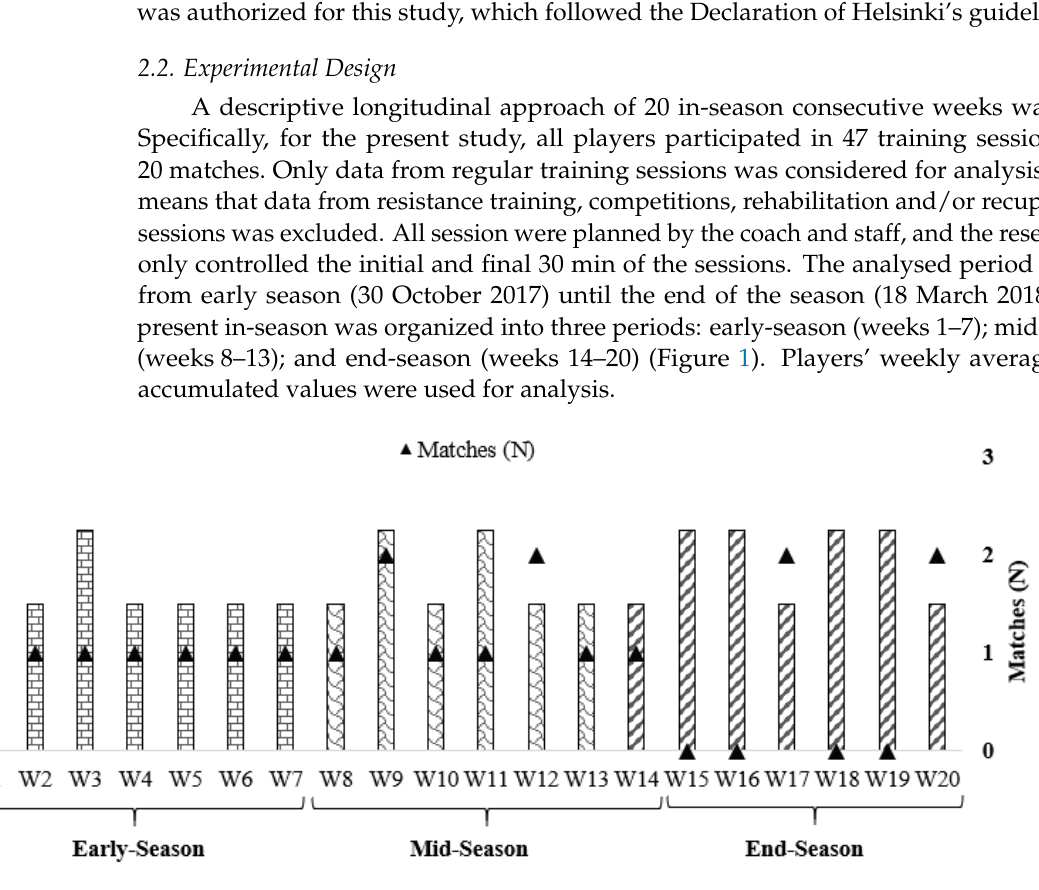
Figure 1. Weekly (W) distribution of training sessions and number of matches across the